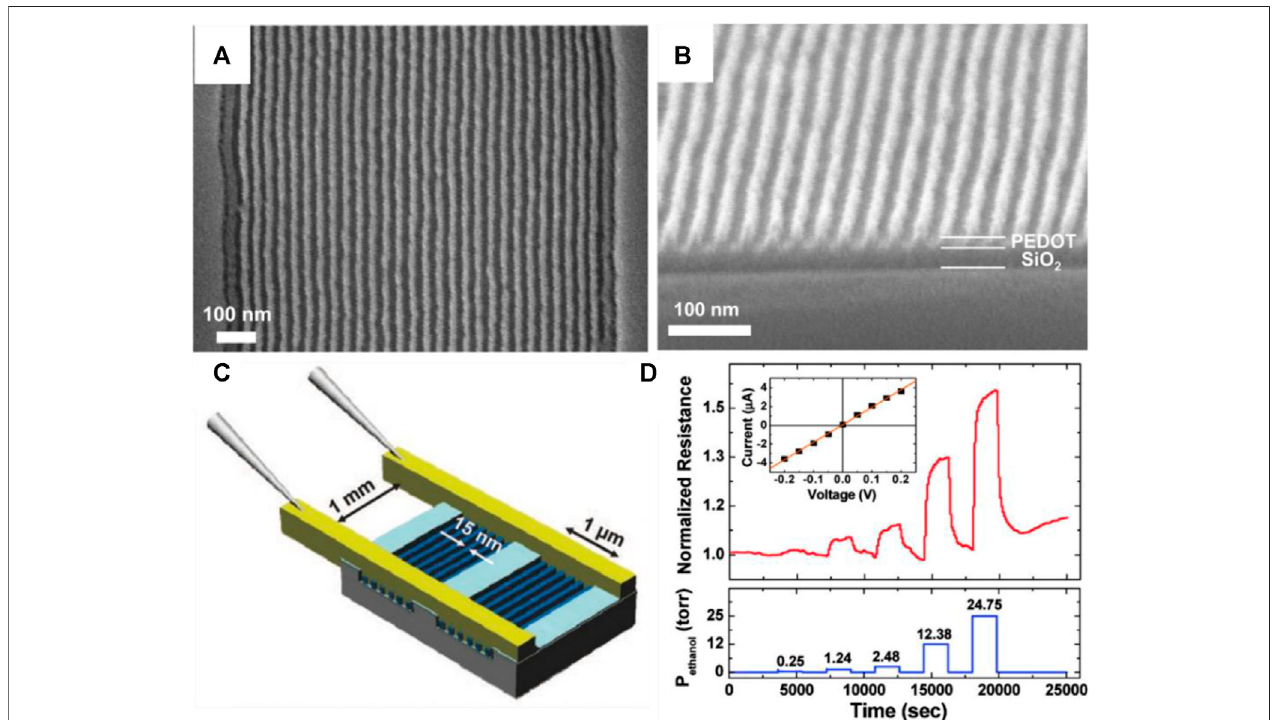
FIGURE 4| SEM micrographs of (A) Top-view and (B) cross-sectional view of PEDOT:PSSnanowiresfabricated using the PS- b -PDMS DSA patternsas RIE etch mask.; (C) Schematic of a PEDOT:PSS nanowire based chemoresistive ethanol sensor; (D) The response of the nanosensor to different ethanol concentrations. Reproduced with permission from ref (Jung et al., 2008).